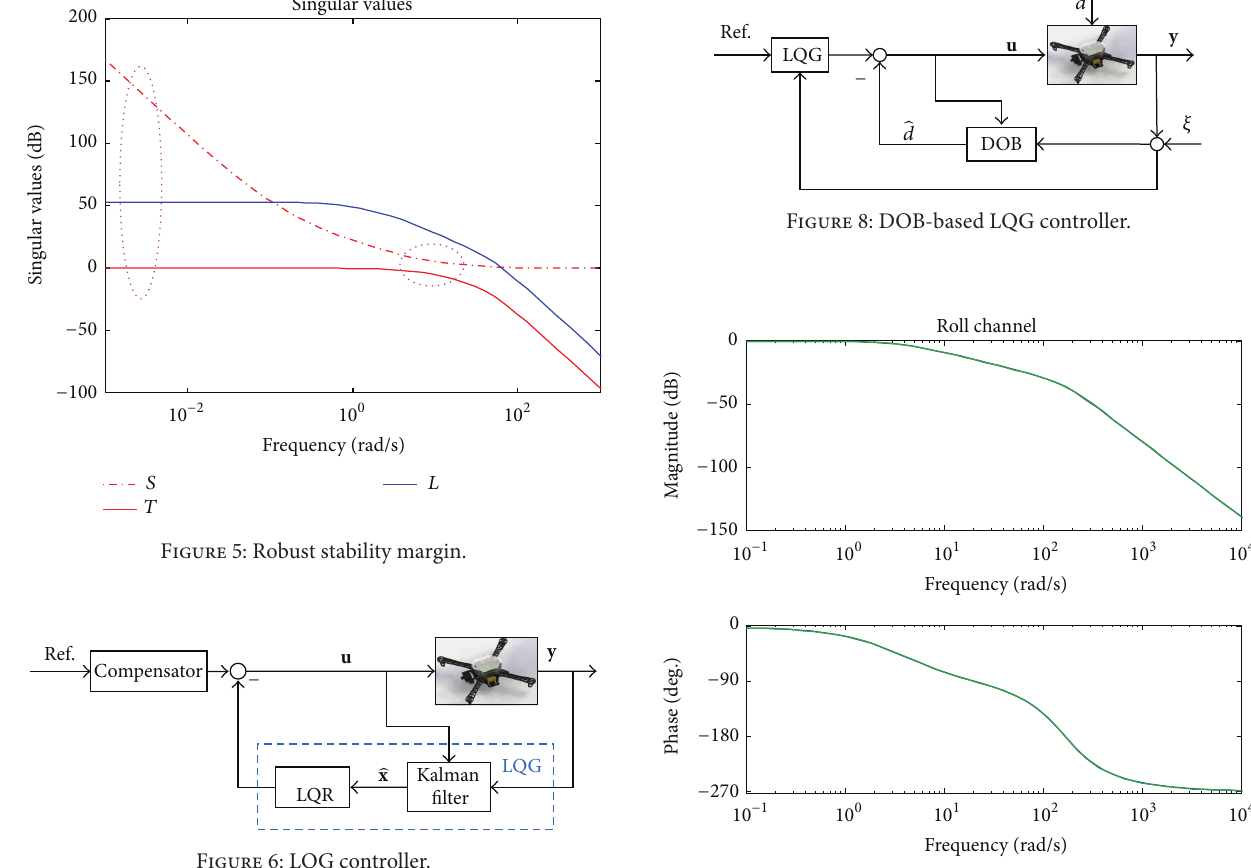
Figure 6: LQG controller.